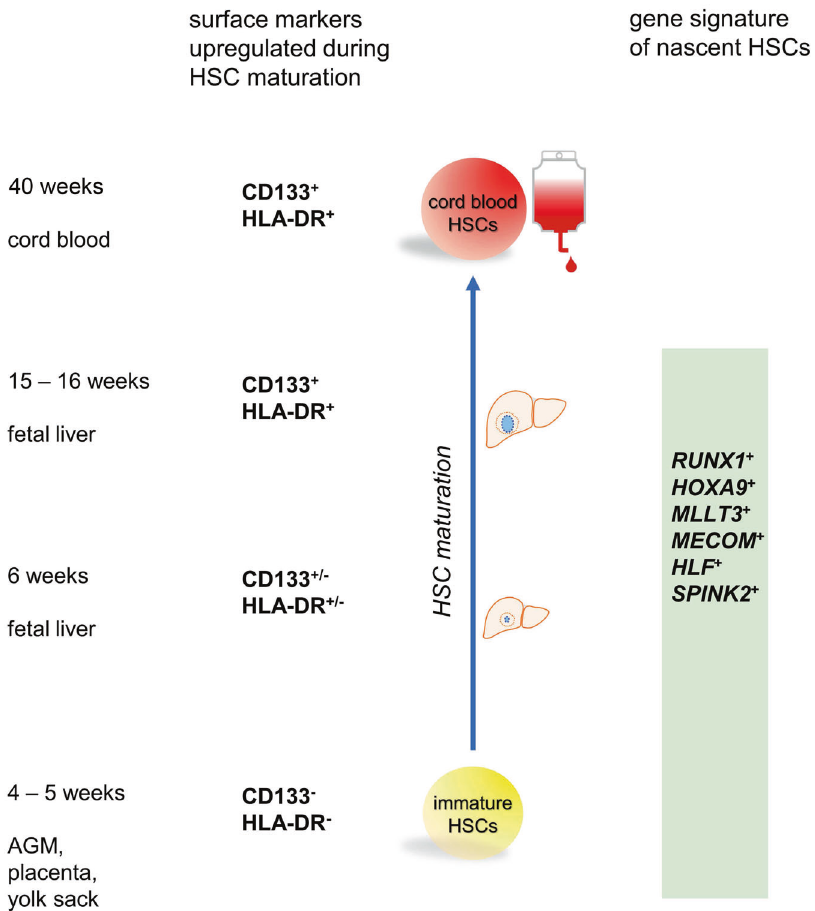
Fig. 1 Landmarks distinguish HSCs and their developmental maturation during ontogeny. Surface markers CD133 and HLA-DR are upregulated during the developmental maturation of HSCs. Gene signature of highly enriched HSC genes identi fi es nascent HSCs as opposed to